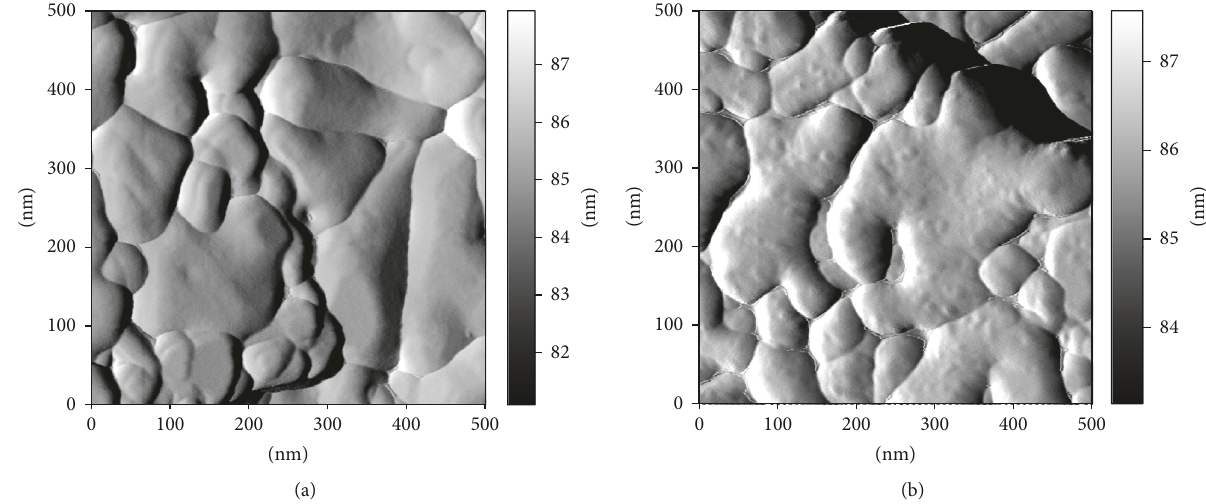
Figure 4: Surface imagens of titanium pyrophosphate obtained by AMF: (a) before europium sorption and (b) after europium sorption.